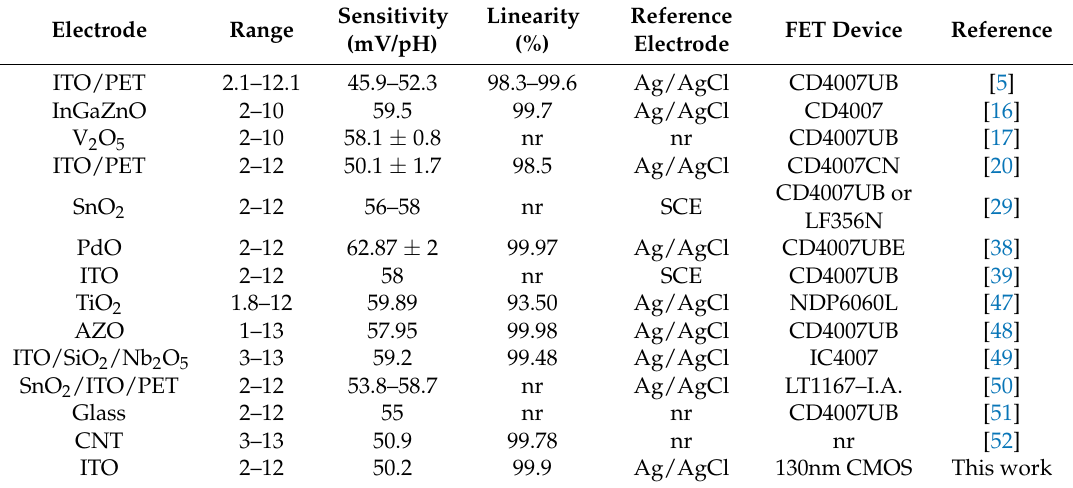
Table 2. Main characteristics of representative EGFET-based pH